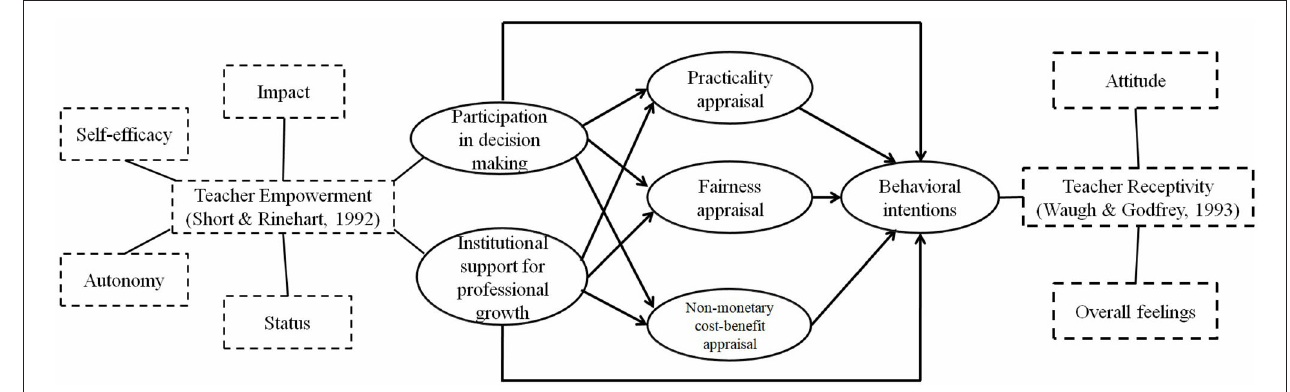
FIGURE 1 | Theoretical framework of the